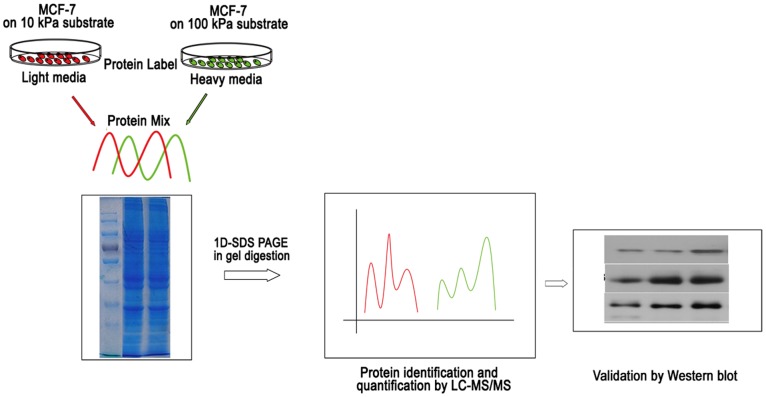
A simple experimental strategy for SILAC-based proteomics. MCF-7 cells were cultured on soft silicone substrate (EY = 10 kPa) in protein Label Light media, and on hard silicone substrate (EY = 100 kPa) in protein Label Heavy media, respectively.Protein lysates were prepared and mixed at a 1∶1 ratio. Sample complexity was reduced prior to LC-MS/MS analysis by fractionation at the protein level through SDS-PAGE. The expression levels of selected proteins were validated by Western Blot analysis. EY: the Young’s modulus.